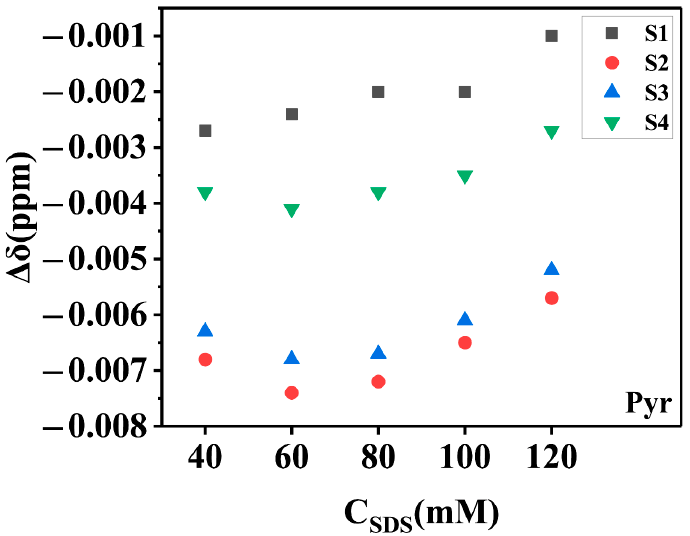
Figure 10. Relative chemical shifts ( ∆δ ) of SDS protons in the single Pyr solubilization system at SDS concentrations from 40 to 120 mM compared to those of the pure SDS solution at the same concentration.